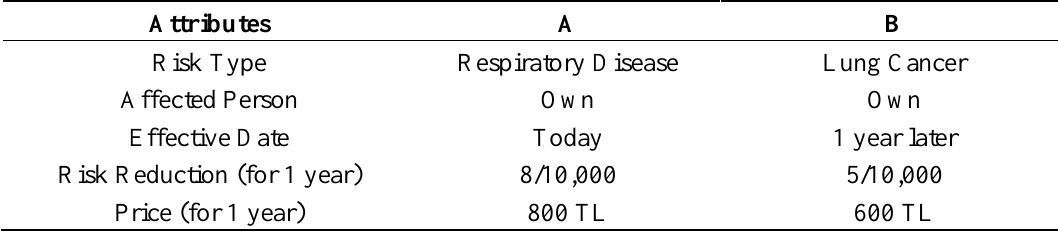
Table A1. An example of a choice